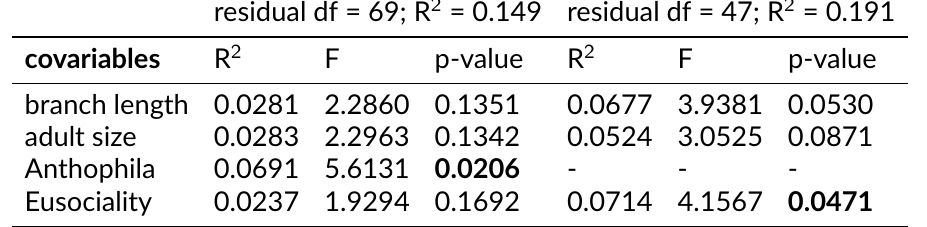
Table S3 – Linear modelling of uncorrected dN/dS ratios in the 88-species subsampled dataset. Corrected dN/dS are obtained using GC-conservative substitutions only. Dis- played results are obtained when simultaneously using all covariables inside a multiple linear model. Phylogenetic independent contrasts where used for all variables so as to account for phylogenetic